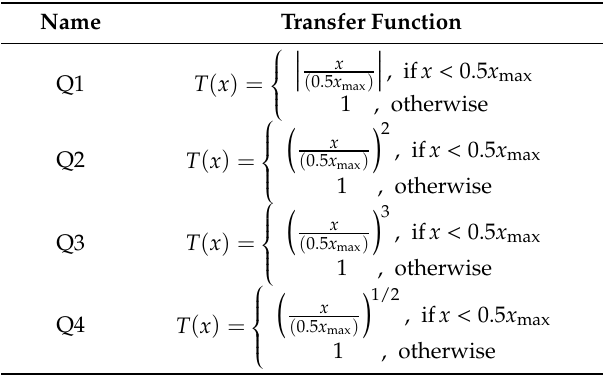
Table 2. The utilized quadratic transfer functions.